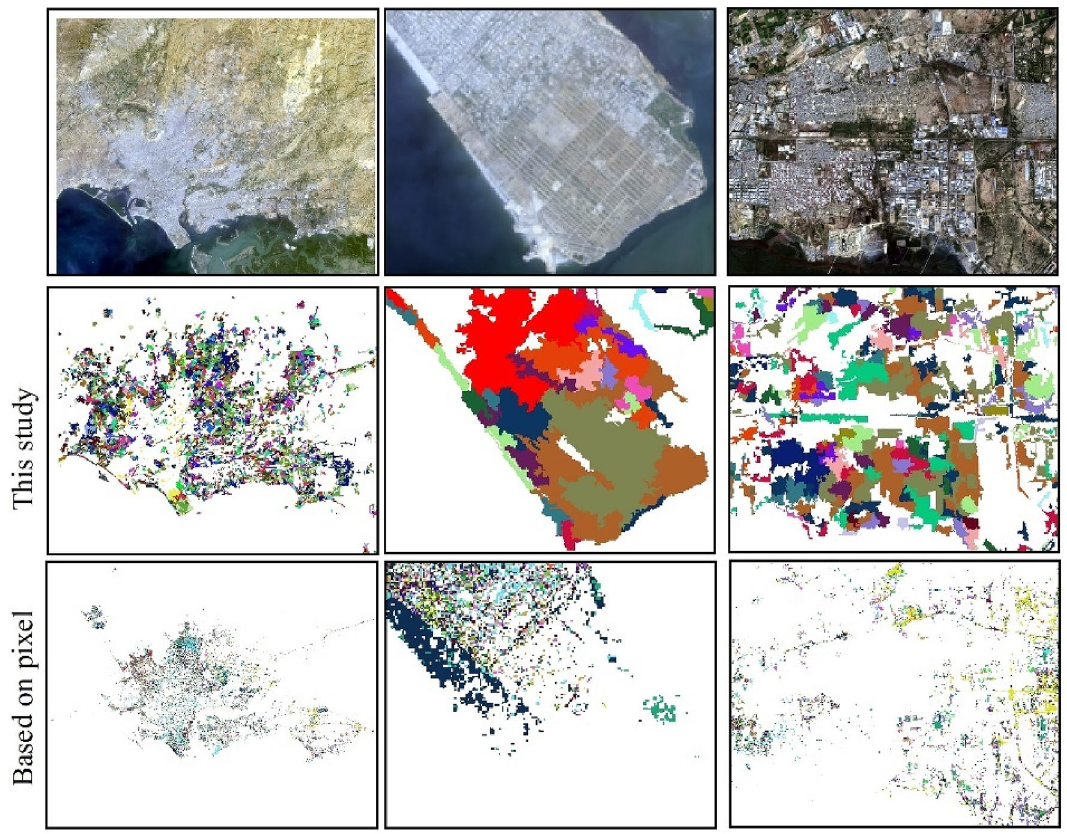
Image data source in the top: Landsat OLI image (2020) from USGS.